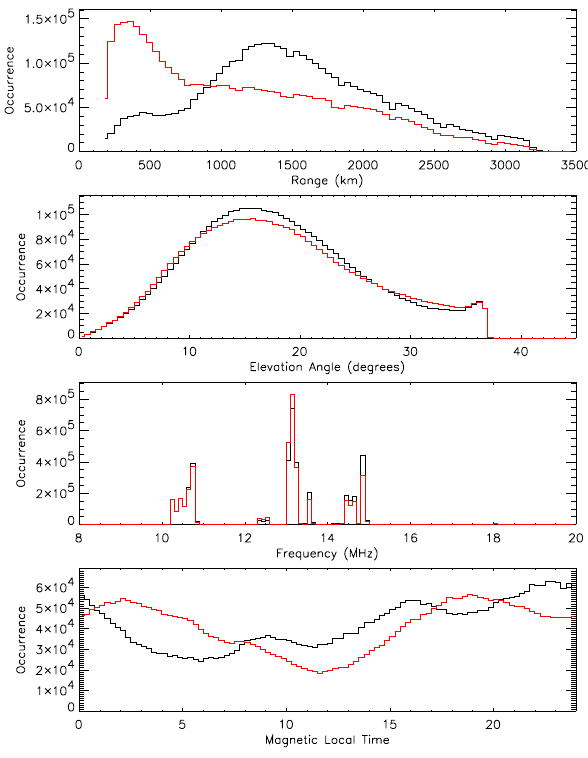
Fig. 2. Statistical histograms of range, elevation angle, frequency, and magnetic local time for Saskatoon beam 3 common mode data from 1997–2001 inclusive. The black curves show the his- tograms when only backscatter with a line-of-sight velocity mag- nitude greater than 100m/s are considered. The red curves show the histograms when only backscatter with a line-of-sight velocity magnitude less than 100m/s are